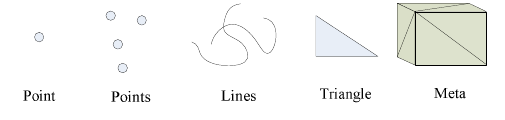
Figure 1. Classification of Spatial